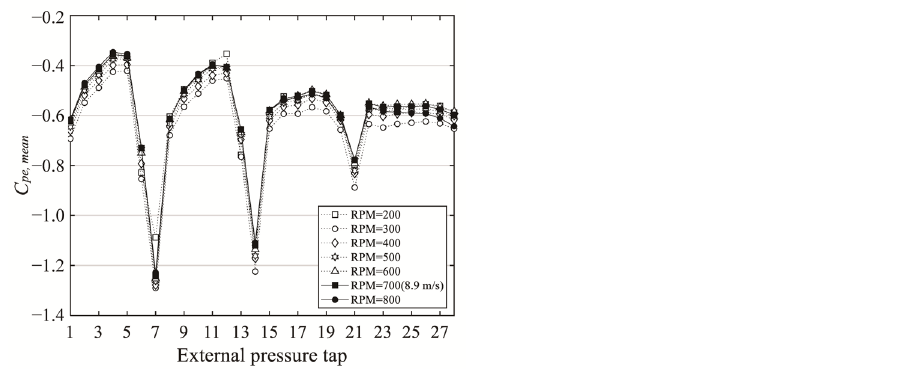
Figure 4. Distribution of the external mean pressure coefficients according to various wind velocities.